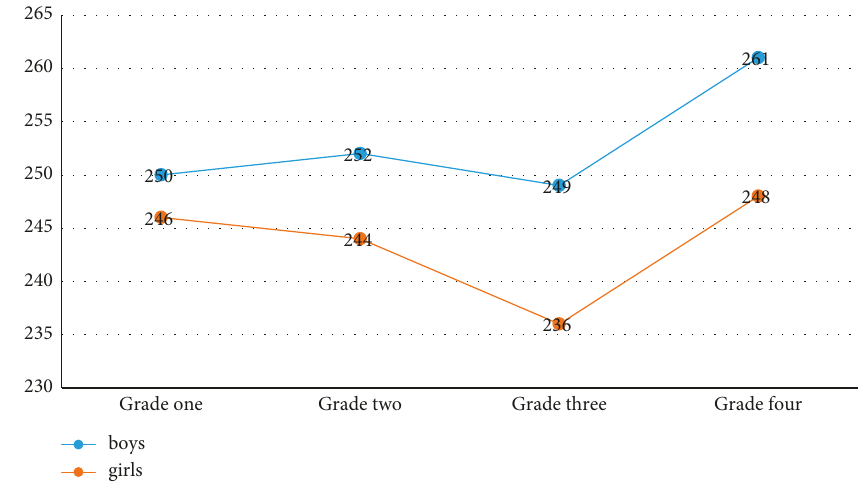
Figure 4: The change curve of boys’ score at 1000m and girls’ score at 800 m. Table 10: Girls’ sit-up scores and grade ratio. Table 11: Boys’ pull-up scores and grade